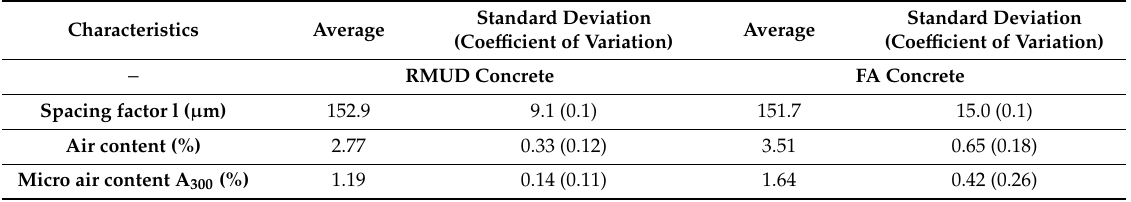
Table 7. Results of the air pore distribution